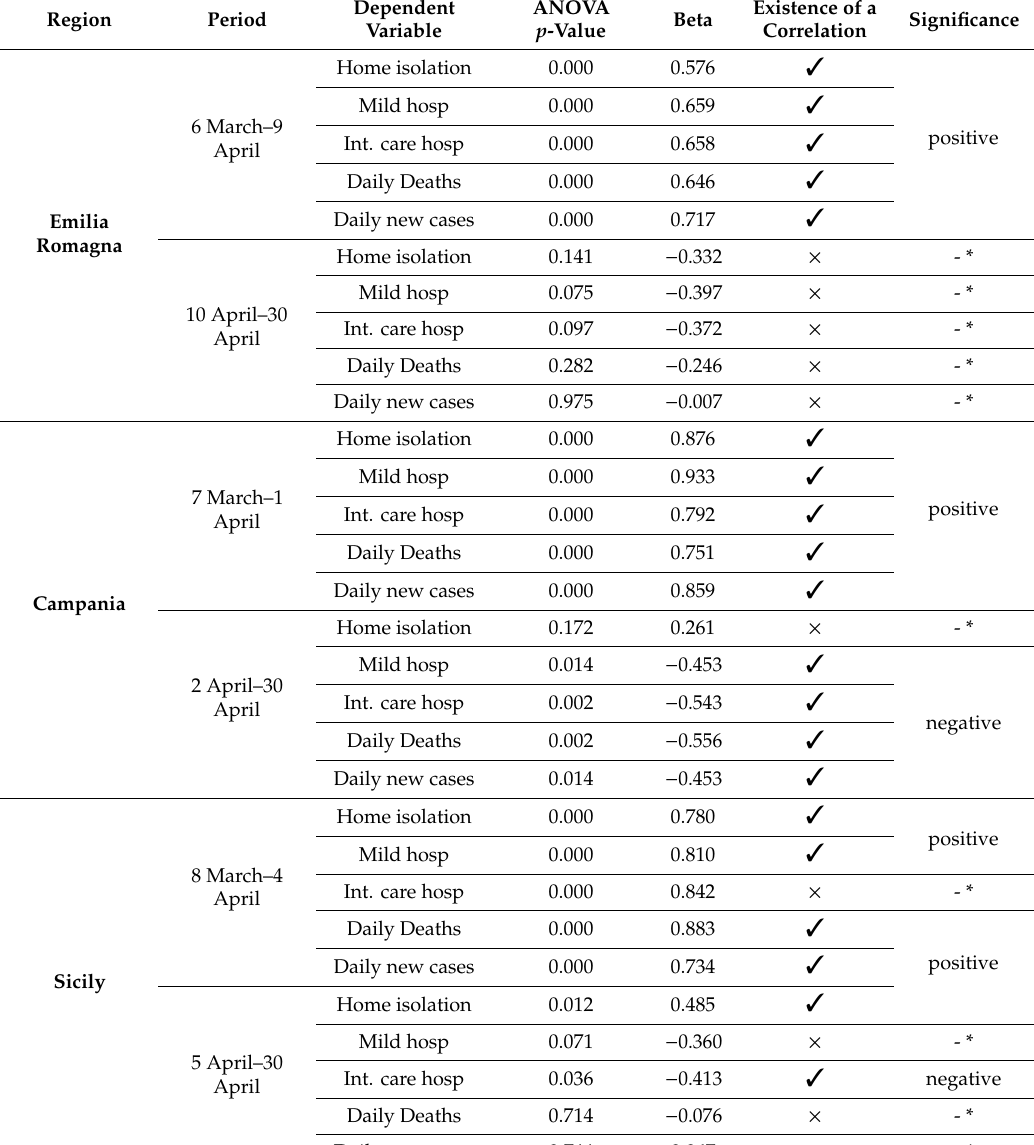
Table 7. Test No. (Independent variable) vs. outcome variables within two periods (Emilia–Romagna, Campania, and